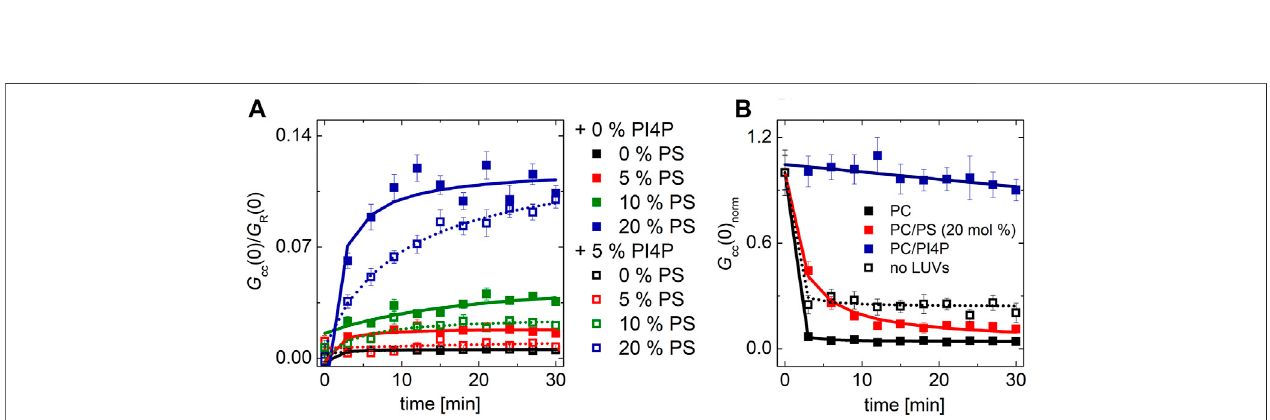
FIGURE 6 | PIP2 transport and extraction. (A) Temporal evolution of the transport readout. The PIP2-accepting membrane contained increasing amount of PS: 0 mol% (black squares), 5 mol% (red squares), 10 mol% (green squares), and 20 mol% (blue squares). The PIP2-donating membrane contained 5 mol% of PIP2 (solid squares), or both PIP2 and PI4P, 5 mol% each (empty squares). (B) Temporal evolution of the normalized cross-correlation amplitude upon Osh6 addition correspondingtothePIP2biosensorreleasefromthePIP2-donatingLUVs.ThePIP2-containingLUVs(5 mol%)weremixedwithLUVscomposedofthefollowing: i) POPC: black squares, ii) POPC/PS (20 mol% of PS): red squares, and iii) POPC/PI4P (5 mol% of PI4P): blue squares. The presented data represent the trends that were observed in minimum three independent